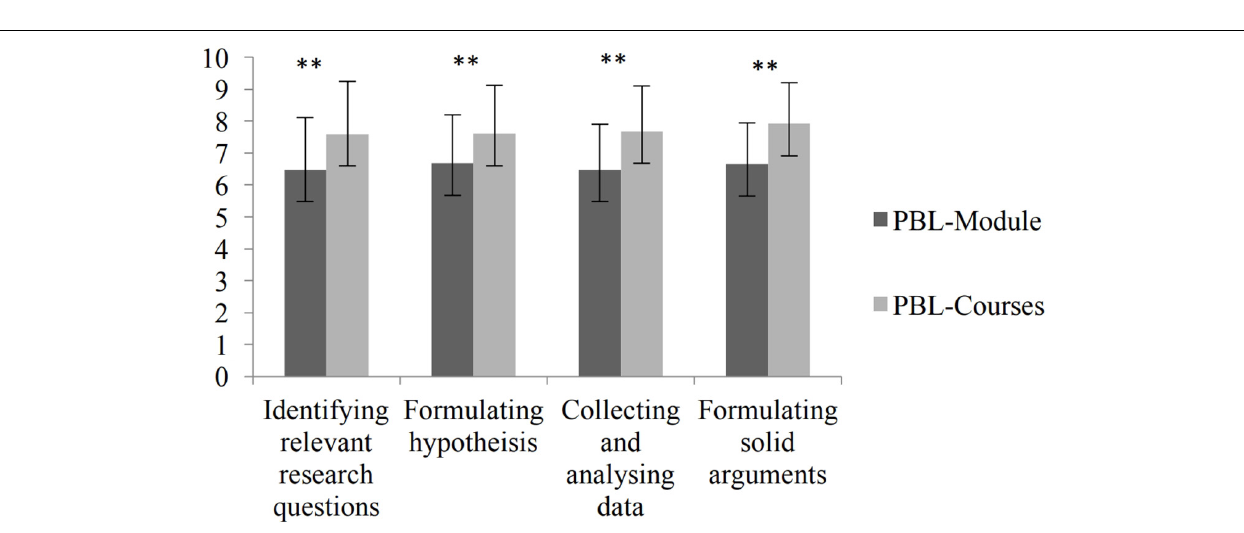
FIGURE 1 | Mean scores given by students in the transversal skills dimension in the PBL-module ( n = 330 students) and PBL-courses ( n = 277 students). ∗∗ p < 0.01 (OC, p = 1.5 × 10 − 19 ; WC, p = 4.5 × 10 − 25 ; TW, p = 2.4 × 10 − 15 ; CSI, p = 1.1 × 10 − 25 ; TM, p = 2.2 × 10 − 19 ; SL, p = 3.8 × 10 − 49 ).